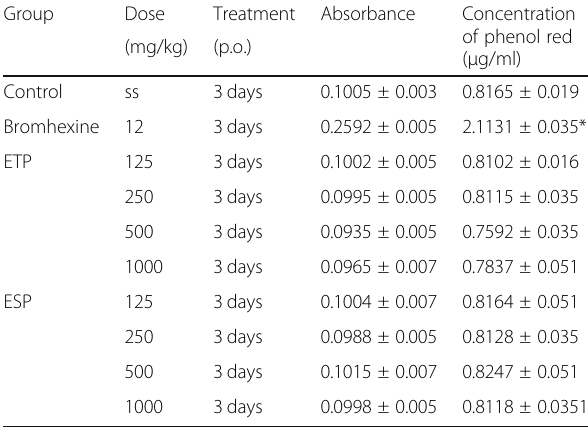
Table 4 Effects of ethanol extracts of propolis of T. fiebrigi (ETP) and S. jujuyensis (ESP) on the amount of phenol red secretion in rats Group